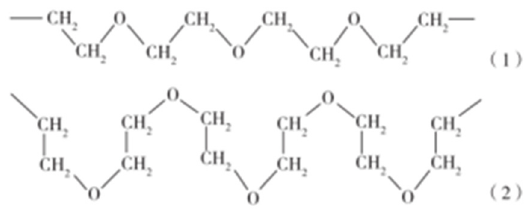
Figure 20. Zigzag and tortuosity molecular structures of polyethylene oxide. (1) zigzag; (2) tortu- osity [70].